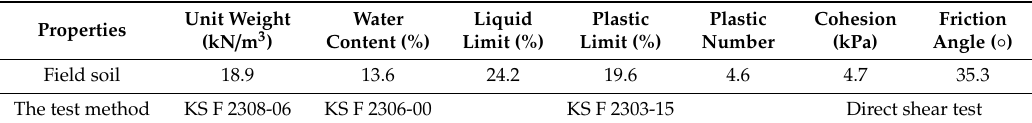
Table 1. Soil properties of field-test roadbed.